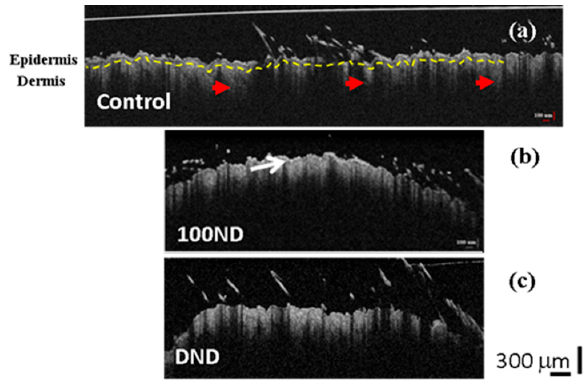
Figure 3. 2D OCT images of black skin samples. ( a ) Control samples exhibit normal structure composed of the epidermis, the dermis separated by a basal layer (yellow dotted line), and hair follicles (red arrow heads). Treated skin with ( b ) 100 ND and ( c ) DNDs. The white arrow shows the stratum corneum layer with a higher reflection. The scale bar depicts 300 µm. The experiment was repeated at least three times independently.